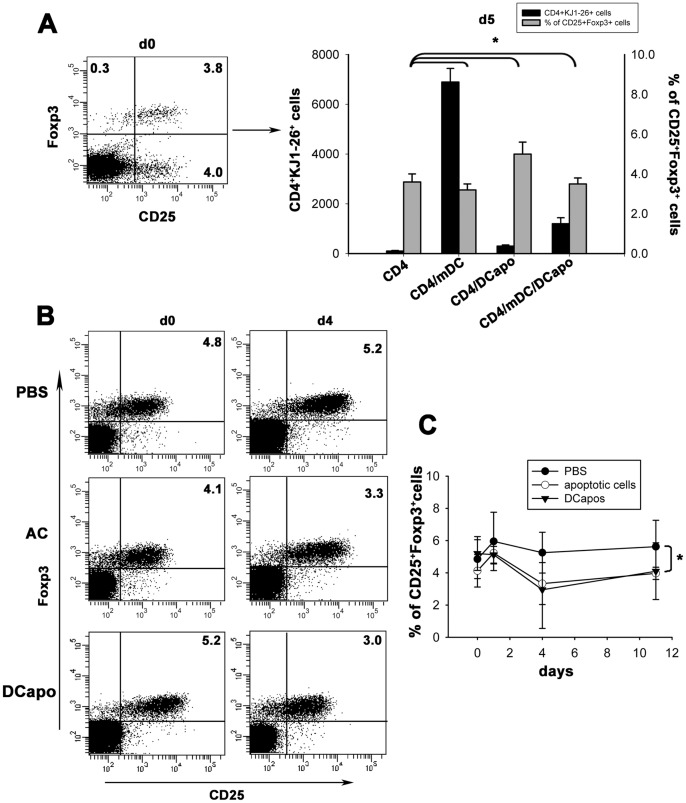
Foxp3+ Tregs were not involved in the inhibitory function of DCapos both in vitro and in vivo.(A) Left, DO11.10 CD4+ T cells (2×105 cells) with Foxp3EGFP were purified, and the CD4+CD25+Foxp3+ cells were measured in a FACS system (numbers indicate percentages). These cells were then co-cultured with OVA323–339-loaded mDCs (2×104) in the presence or absence of DCapos (2×104 cells) for 5 days in vitro. On the fifth day, the cells were harvested and the numbers of CD4- and KJ1-26-positive cells were determined by FACS analysis (black). The proportion of CD4+KJ1-26+CD25+Foxp3+ cells was determined by FACS (grey). Data are presented as mean ± SD of triplicate wells, and the results represent 2 separate experiments. (B, C) Apoptotic cells (AC), DCapos, or phosphate-buffered saline (PBS) was injected into the peritoneal cavity of Foxp3EGFP mice (PBS, n = 5, AC, n = 8, DCapo, n = 5). The CD4+CD25+Foxp3+ cells in the peripheral blood were assayed by FACS at days 0, 1, 4, and 11 (numbers indicate percentages). Data in b–c are representative of 3 separate experiments. *p > 0.05.